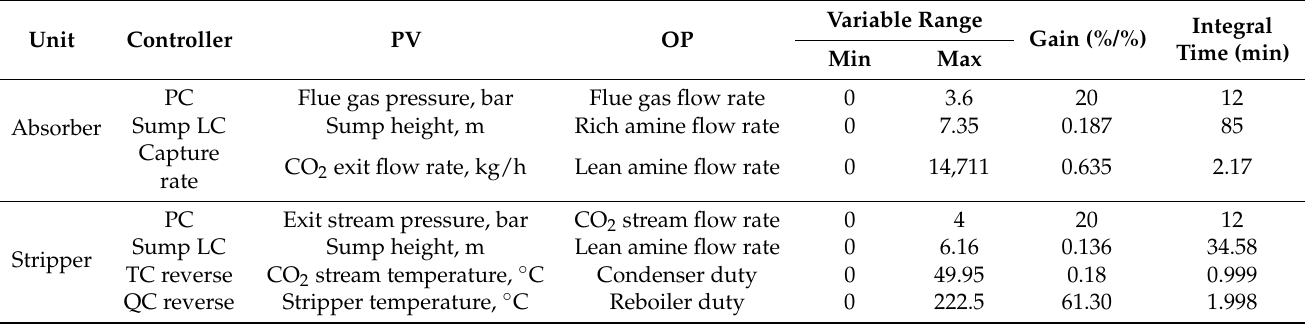
Table 5. Tuned controller